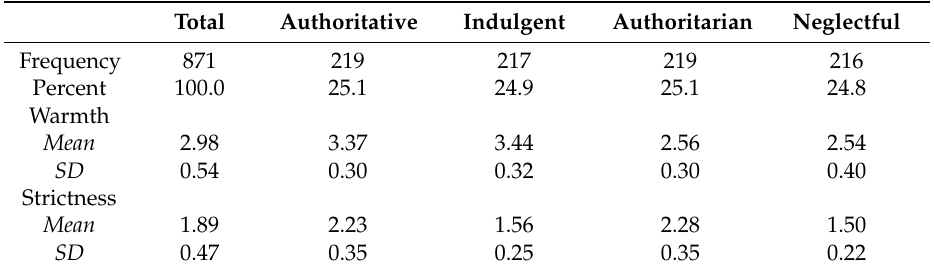
Table 1. Numbers of Cases in Parenting Style Groups, Mean Scores, and Standard Deviations on Main Measures of Parental